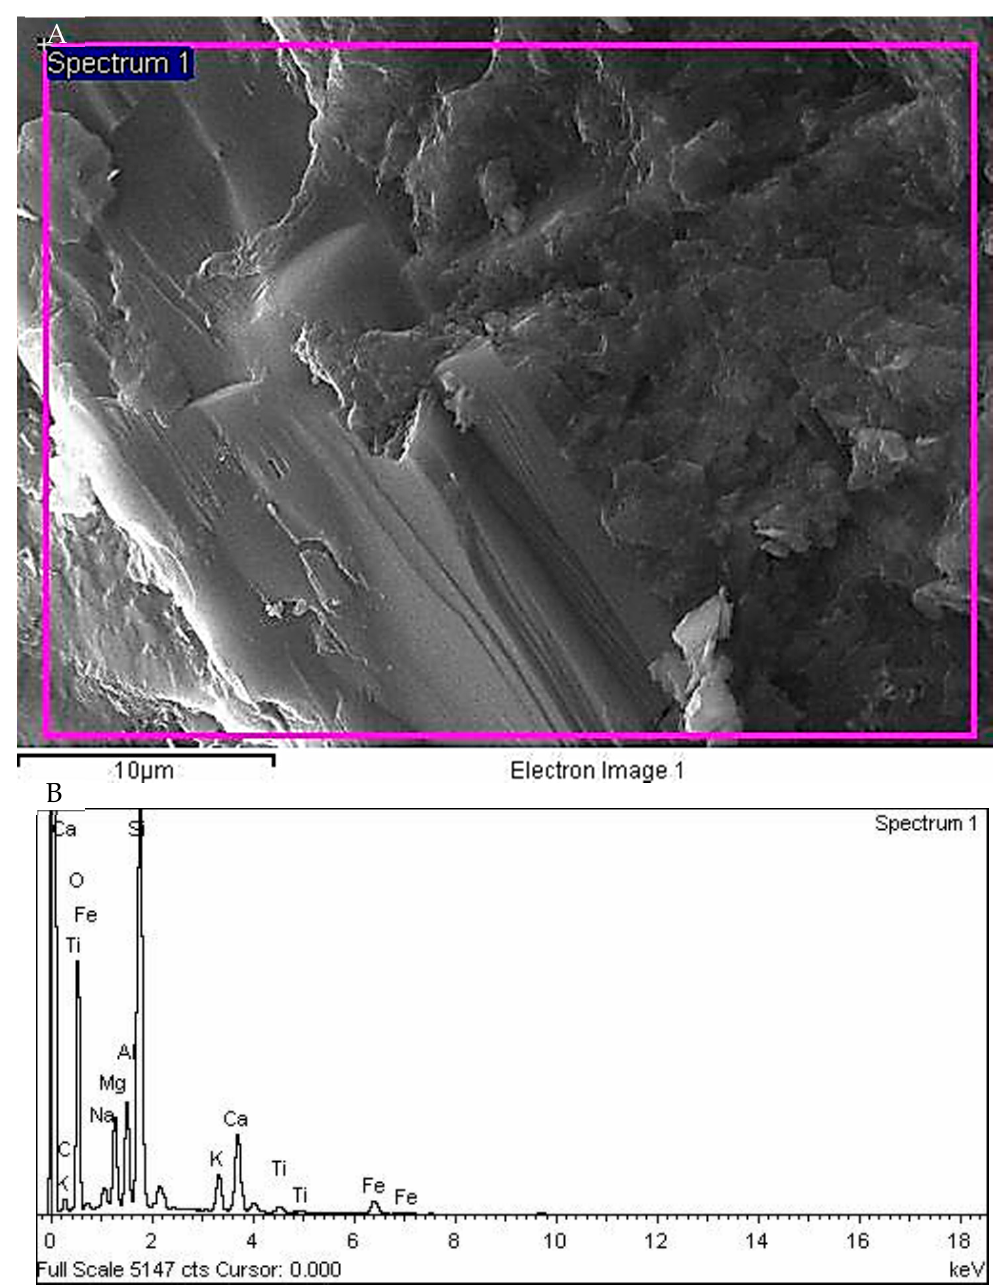
Figure 8. ( A ) FESEM image and ( B ) EDX spectrum of Segamat basalt sample. Element weight percentage (wt.%): C (0.91 wt.%), O (53.45 wt.%), Na (1.44 wt.%), Mg (4.76 wt.%), Al (5.01 wt.%), Si (22.11 wt.%), K (2.62 wt.%), Ca (6.25 wt.%), Ti (0.71 wt.%), and Fe (2.74